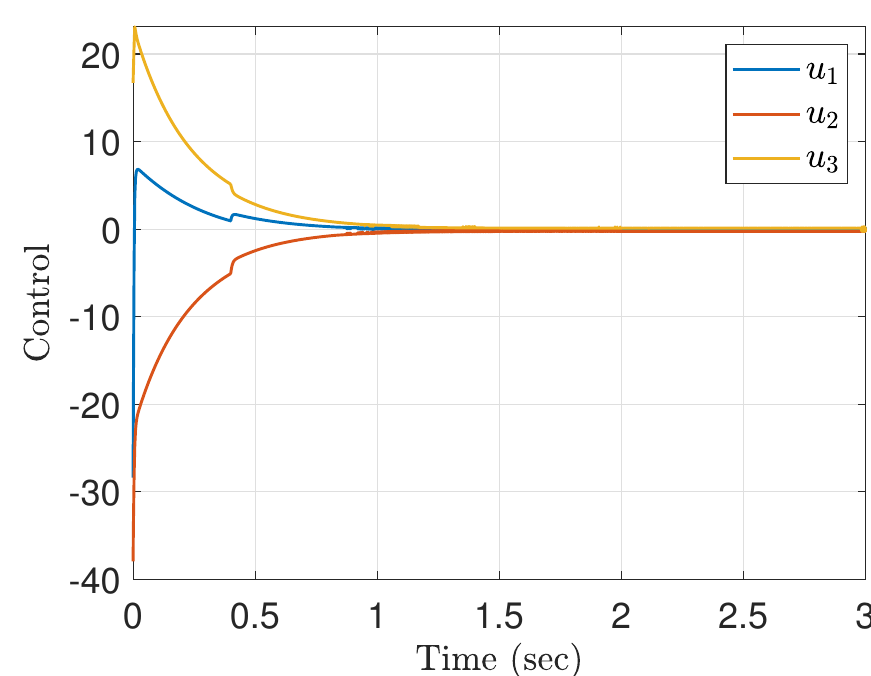
Figure 2. Control signals of the closed-loop